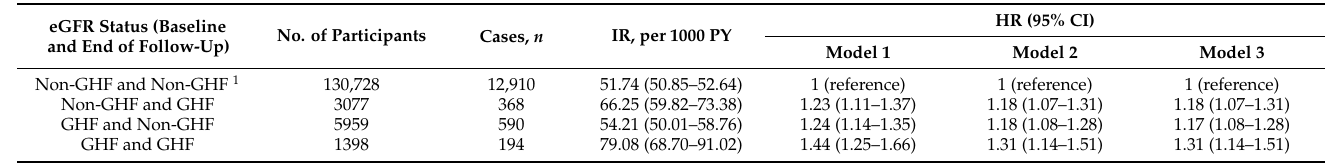
Table 4. Incidence and hazard ratios for the development of NAFLD according to GHF status at baseline and at the end of the follow-up.